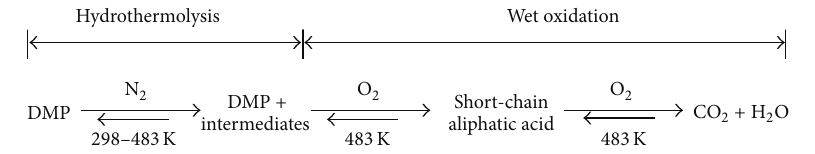
Figure 10: Two stages for the decomposition of DMP via